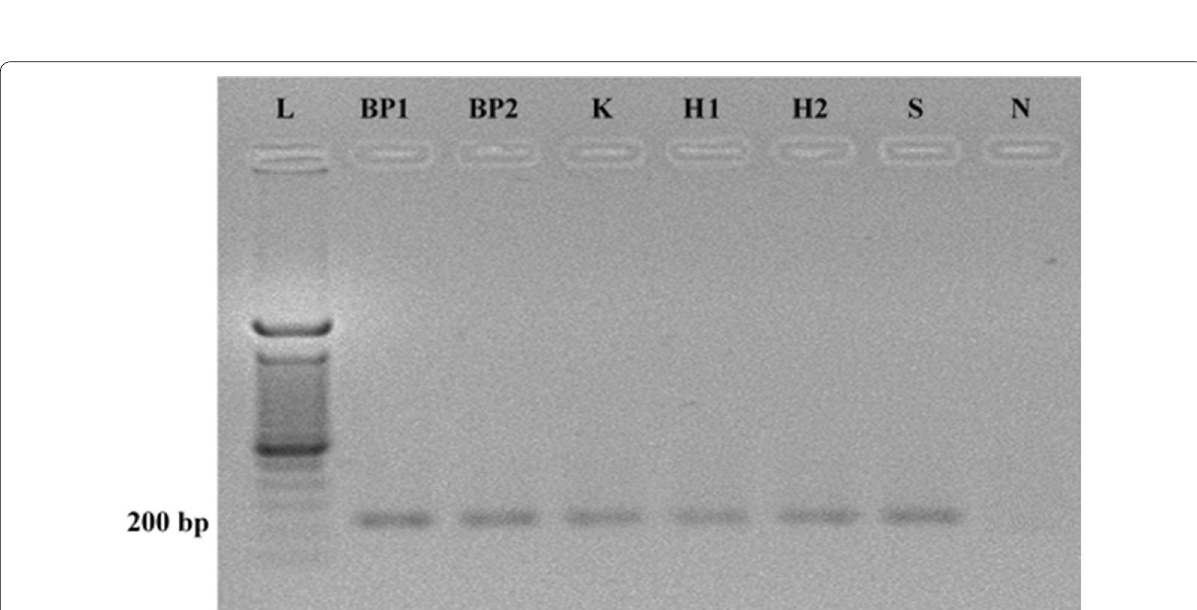
Fig. 2 Agarose gel electrophoresis of PCR amplified product of V2–V3 region of 16S rRNA gene from bacterial genomic DNA which was extracted from wound tissue debridement specimen No. 1 using different extraction methods. L 100 bp DNA ladder marker, N blank/Negative